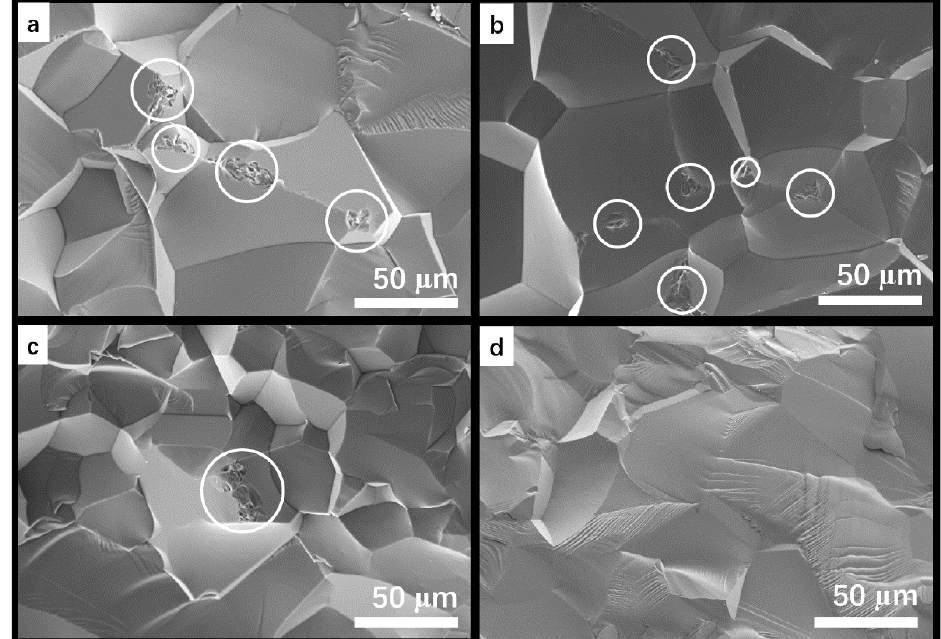
Figure 6. SEM of the fracture surfaces of the obtained ceramics: ( a ) AlN–Al 2 O 3 –0.5% Y 2 O 3 ; ( b ) AlN– Al 2 O 3 –1.0% Y 2 O 3 ; ( c ) AlN–Al 2 O 3 –10% LA and ( d ) AlN–Al 2 O 3 –20% LA. Residual pores were shown in the circles.